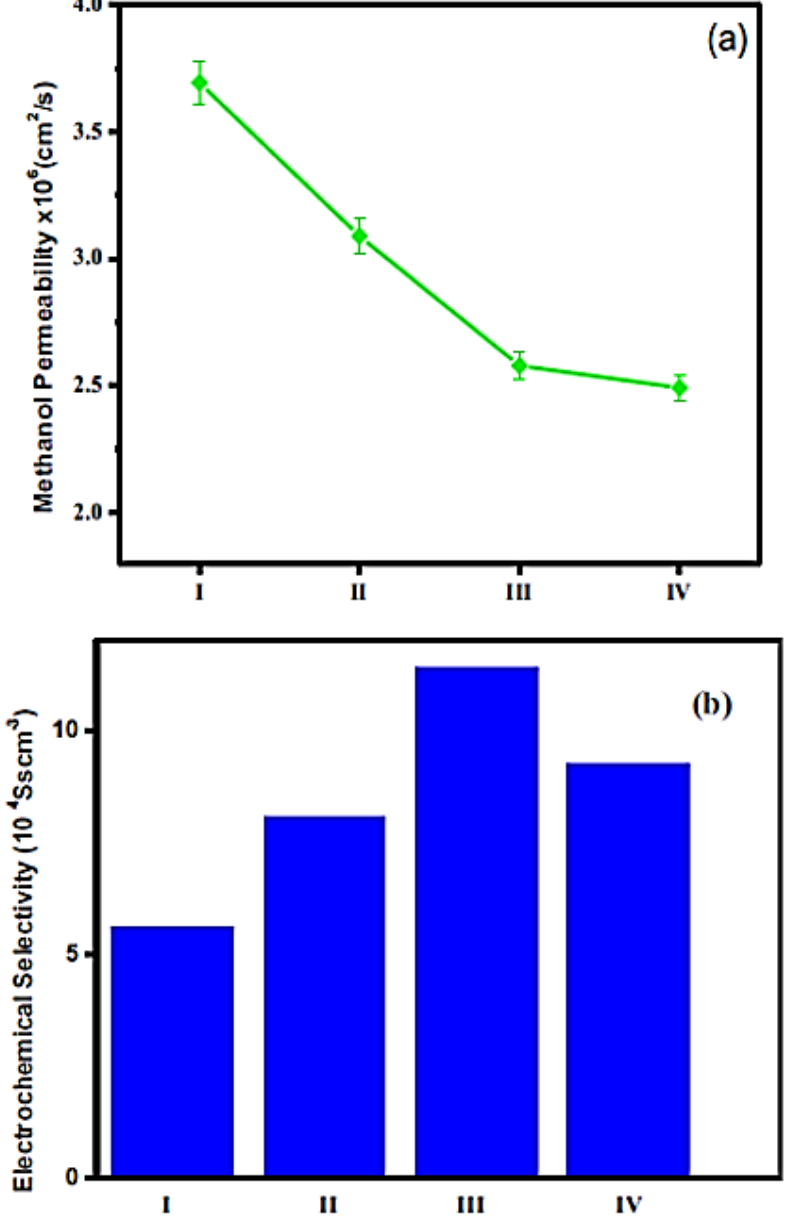
Figure 6. ( a ) Methanol permeability of PC-PVA blend, PC-PVA/s-TiO 2 -I, PC-PVA/s-TiO 2 -II, and PC-PVA/s-TiO 2 -III hybrid nanocomposite membranes measured at 70 °C; and ( b ) electrochemical selectivity of PC-PVA blend, PC-PVA/s-TiO 2 -I, PC-PVA/s-TiO 2 -II, and PC-PVA/s-TiO 2 -III hybrid nanocomposite membranes [99]. PC-PVA = pectin-poly(vinyl alcohol); PC-PVA/s-TiO 2 = pectin-poly(vinyl alcohol)/sulfonated titanium dioxide. Reproduced with permission from Elsevier.